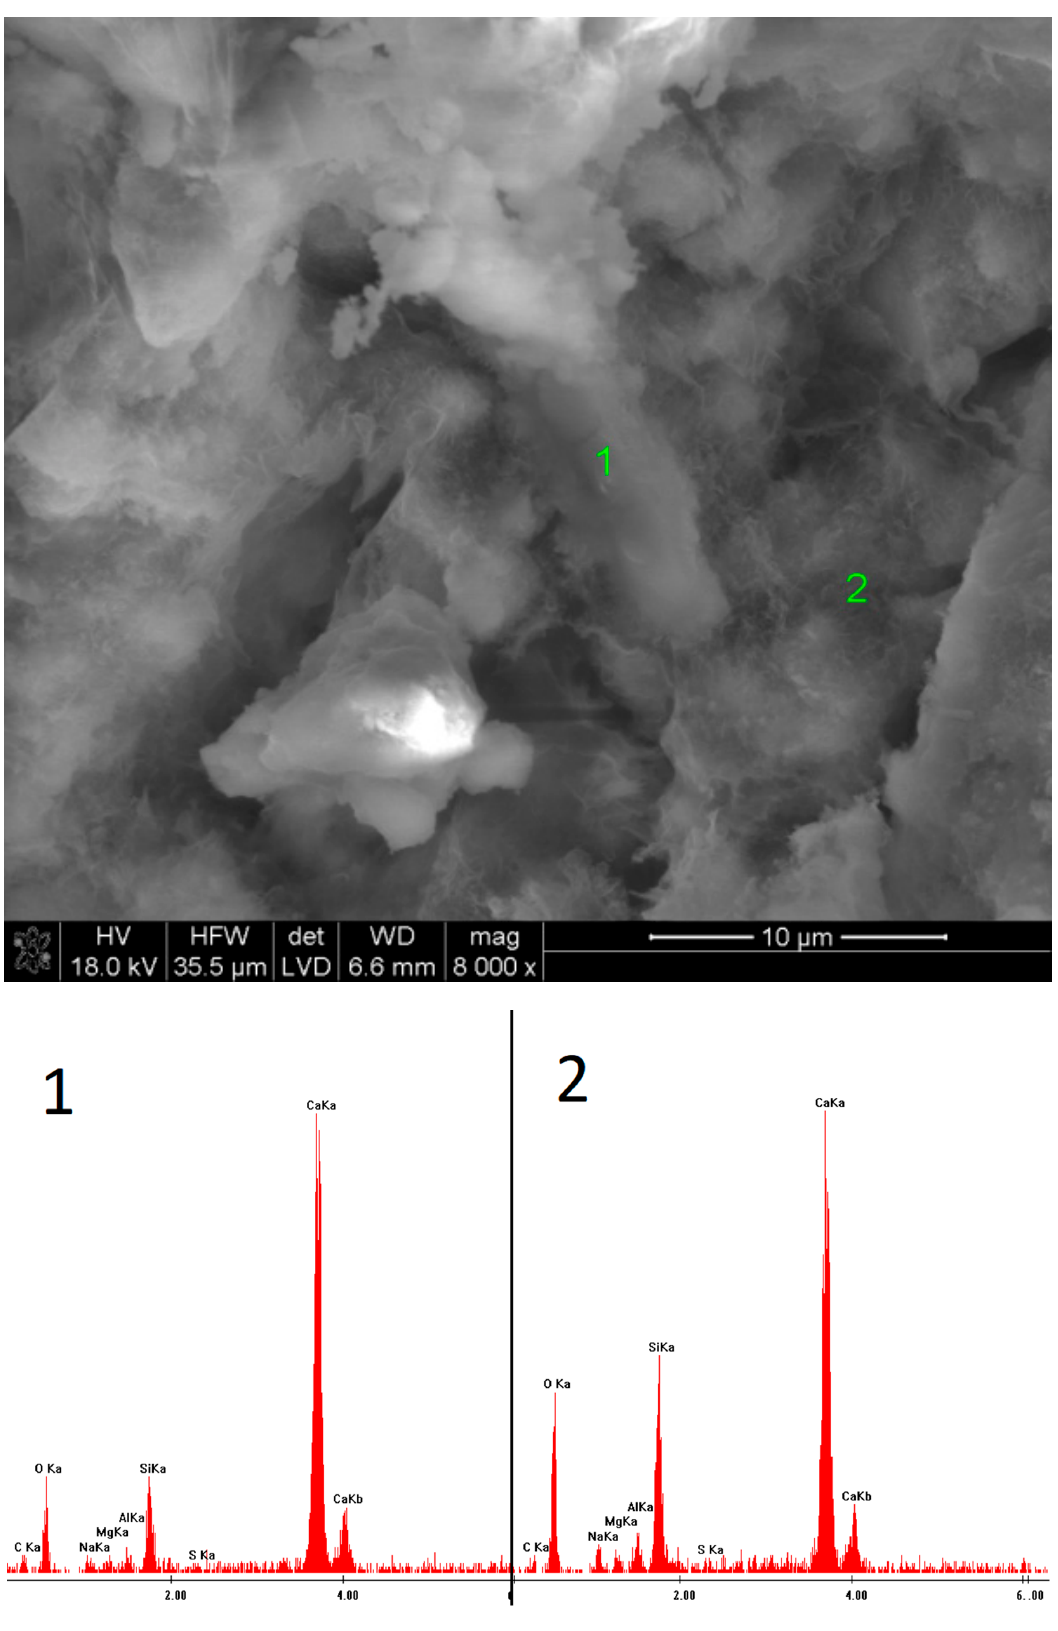
Figure 18. Microstructure of slag paste activated with sodium formate after 360 days of curing— SEM + EDS; 1 , 2 —hydration products covering the slag grains.